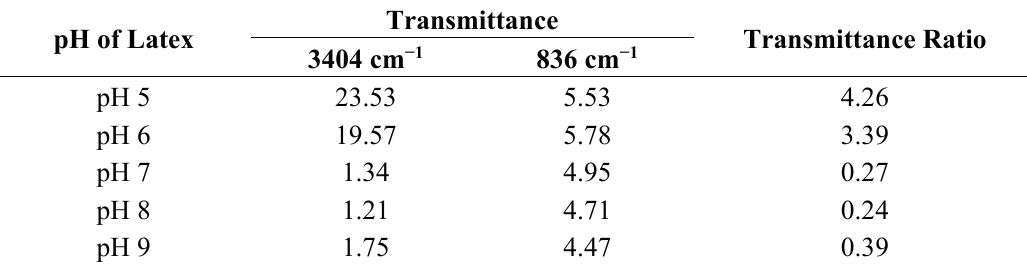
Table 2. The transmittance ratio of the peak 3404 cm − 1 to 836 cm − 1 of LNR samples prepared at different